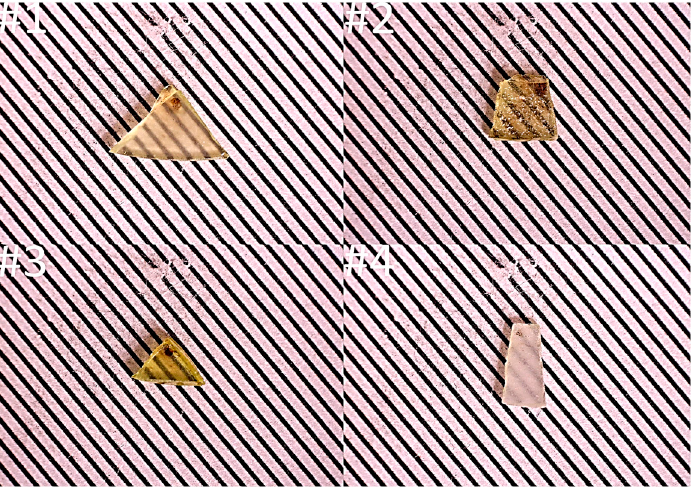
Figure 1. The samples under study: #1 LuAG:Ce SCF/YAG SC, h SCF = 15 μ m; #2 LuAG:Ce SCF/YAG SC, h SCF = 37 μ m; #3 LuAG:Ce SCF/YAG SC, h = 78 μ m; #4 YAG SC substrate (undoped).